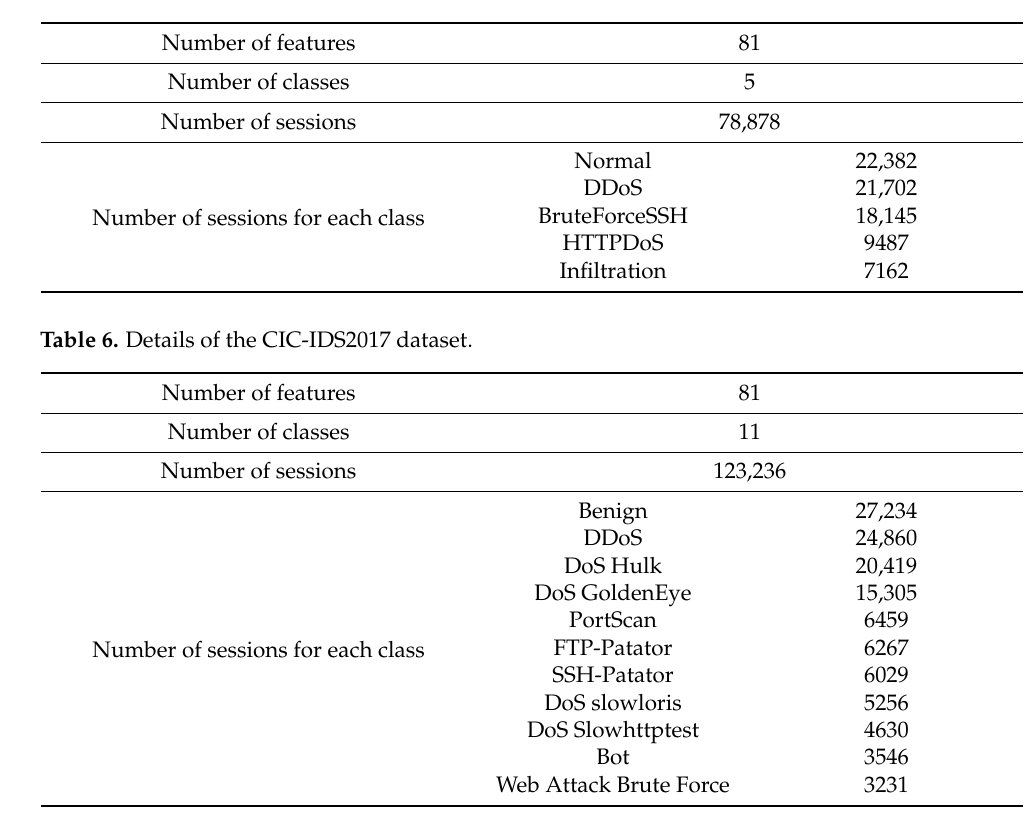
Table 5. Details of the ISCXIDS2012 dataset.